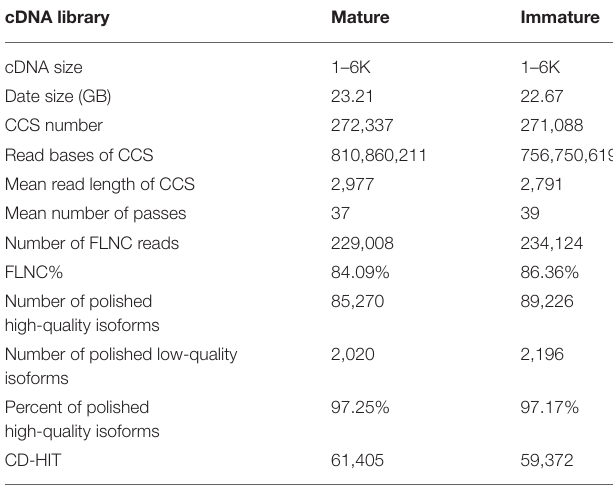
TABLE 1 | Statistics of the PacBio Iso-sequencing